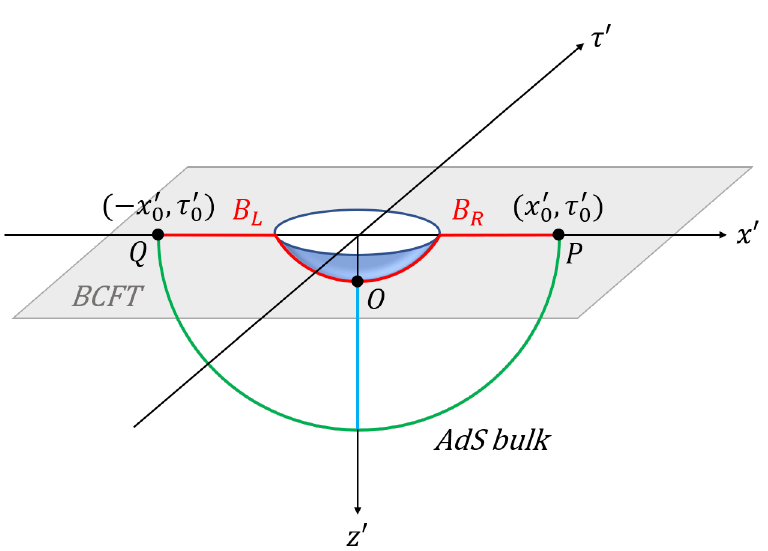
Figure 11. The connected phase of the extremal surface for the black hole. In this phase, the extremal surface (green curve) is a geodesic connecting the endpoints of the black hole region. The cross section of the entanglement wedge is a geodesic (blue curve) connecting the extremal surface and the EOW brane, which is determined by minimizing the generalized reflected entropy (the terms in bracket in (3.2)) between the left and right bulk. Note that from the bulk point of view, there is conformal matter distributed on the EOW brane, which is treated as a part of the